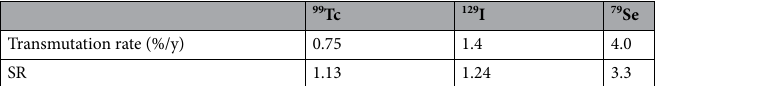
Table 3. Transmutation rate and support ratio of LLFPs in a fast breeder reactor with MAs and LLFPs.